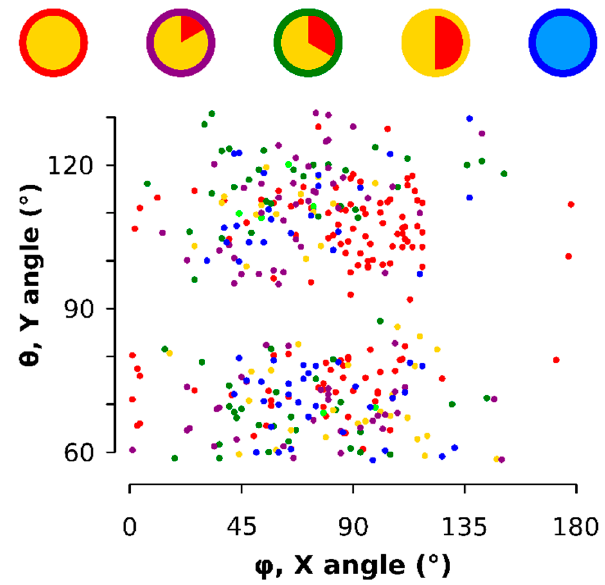
Figure A5. Scatter diagram of the 3D orientation of each particle on the TEM support. The time points are color-coded as shown on top. A 90° Y angle is avoided whereas the X angle broadly centers around 90°.